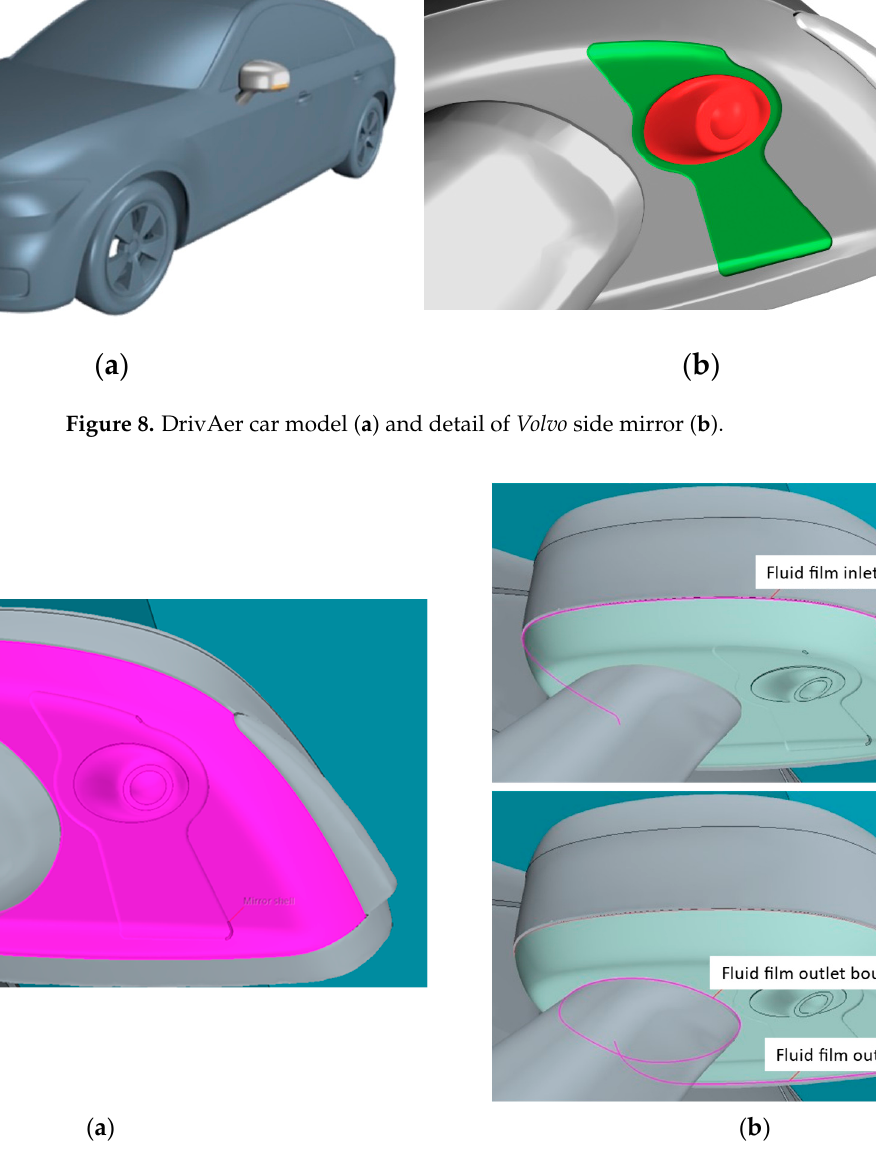
Figure 9. Shell region created on the underside of the mirror ( a ) and inlet/outlet system through the shell region ( b ).